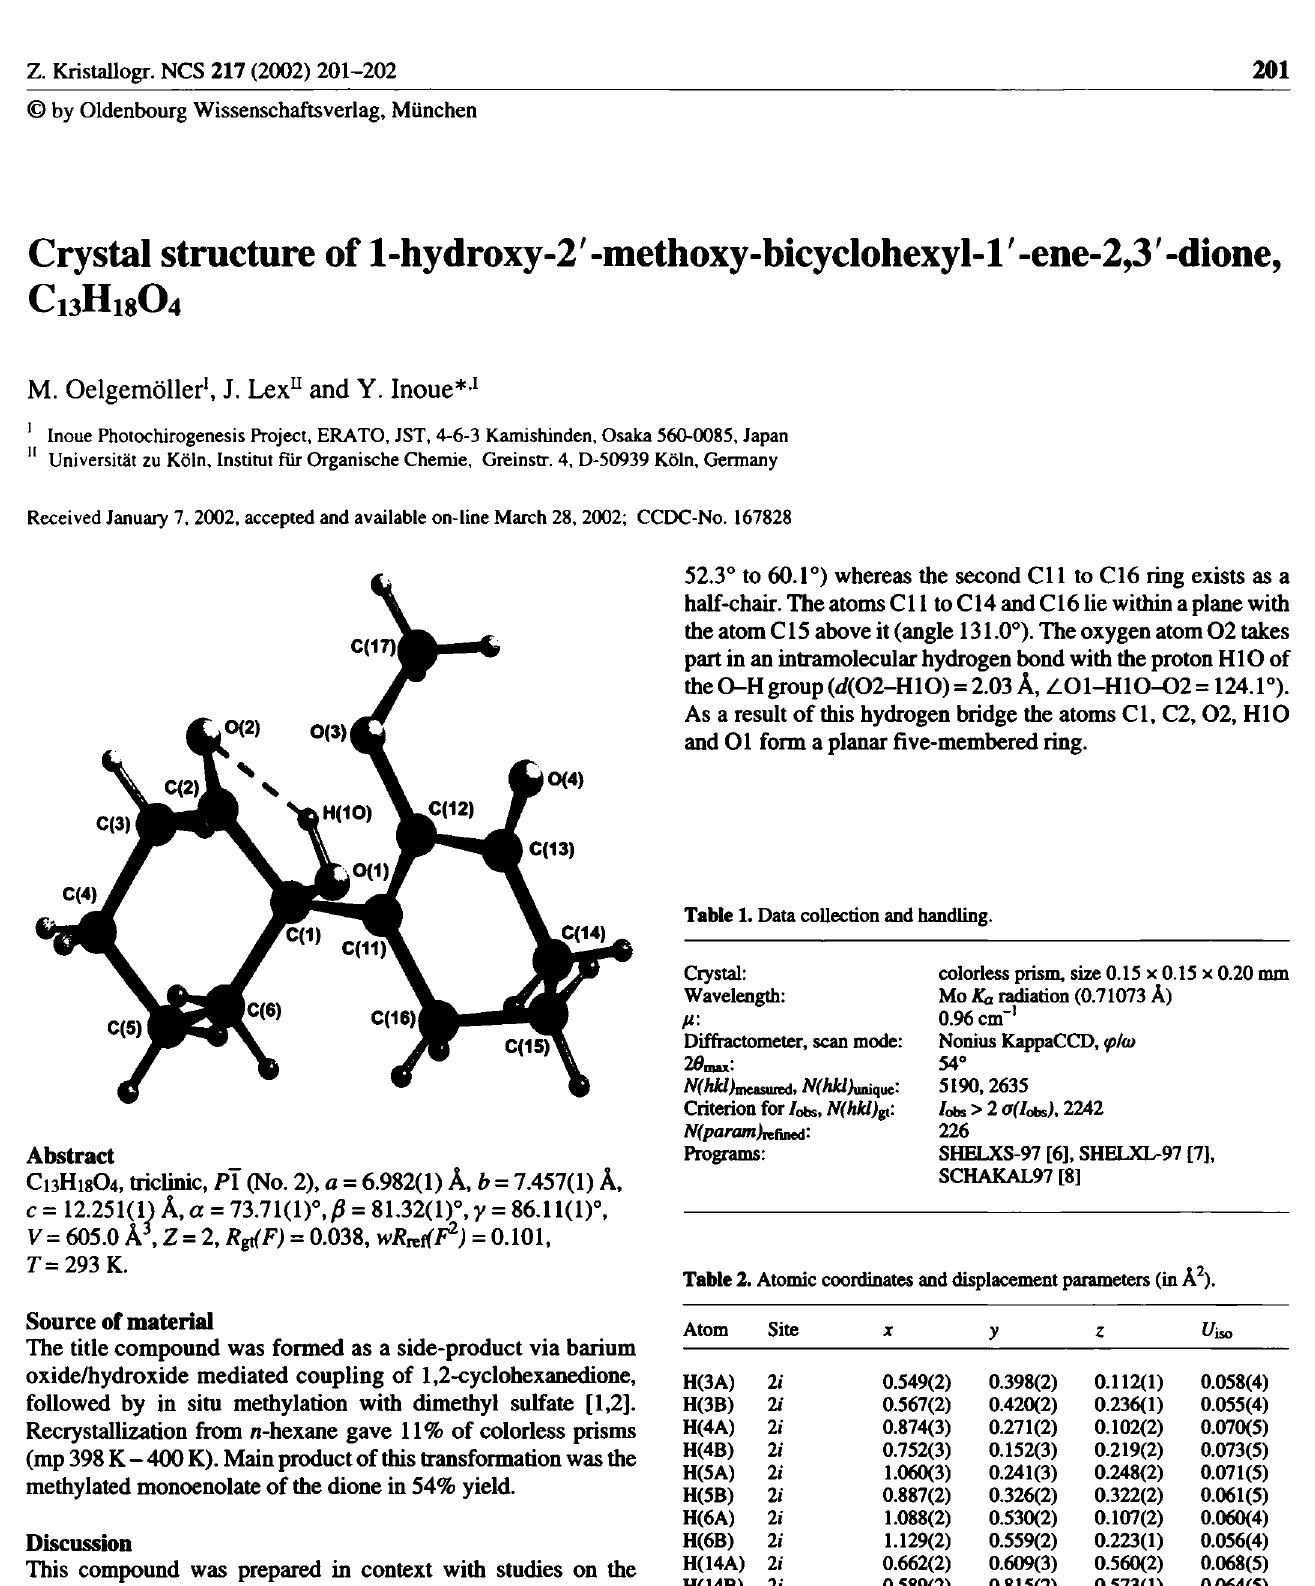
Table 2. Atomic coordinates and displacement parameters (in Â 2